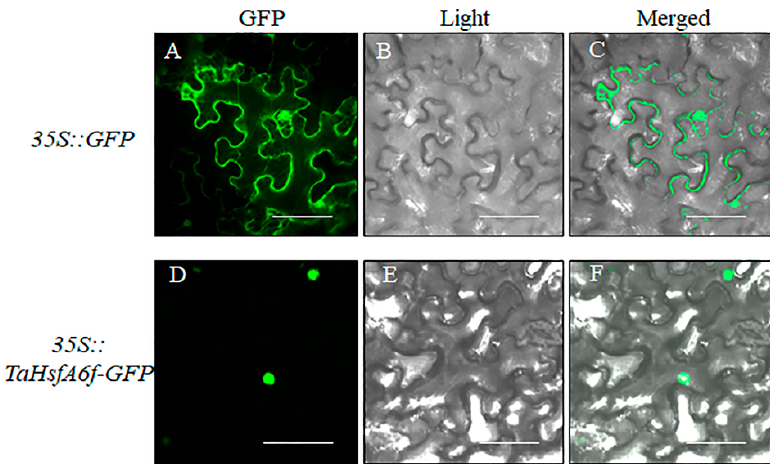
Figure 2. Subcellular localization of TaHsfA6f protein by Nicotiana benthamiana leaf epidermal cells transient expression. 35S::GFP and 35S::TaHsfA6f-GFP plasmids were transformed into Nicotiana benthamiana leaf epidermal cells and signals were visualized with laser confocal-scanning fluorescence microscopy. From left to right, the photographs were taken in the dark-field for green fluorescence (GFP) ( A , D ), under bright-field for the morphology of the cell (Light) ( B , E ), and overlays of the GFP signals and bright-field (Merged) ( C , F ). The scale bars represent 40 µm.